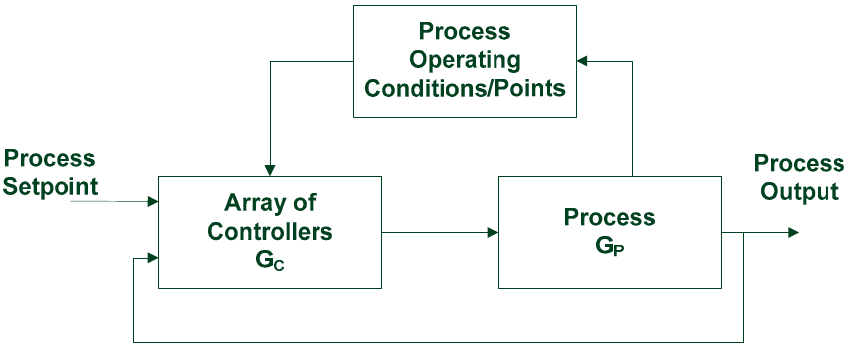
Figure 6. Schematic diagram of gain scheduling of the controller [38].